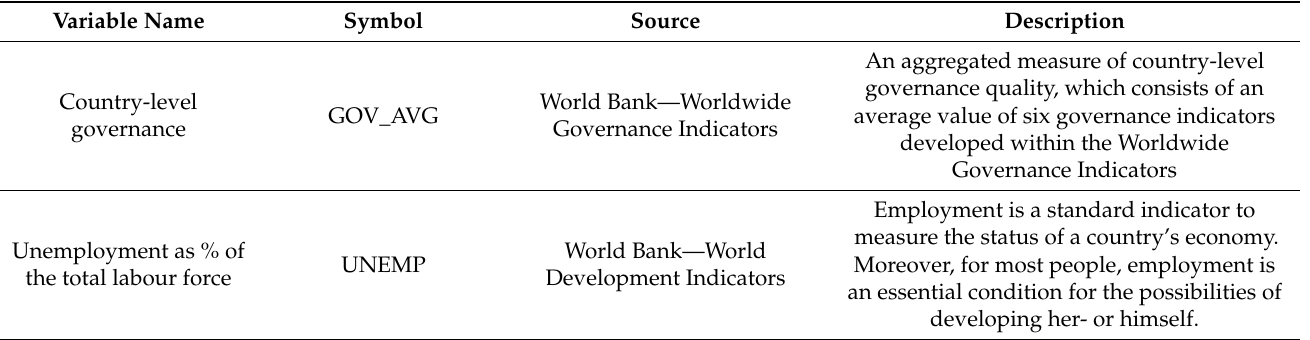
Table 1. Description of variables and data sources.